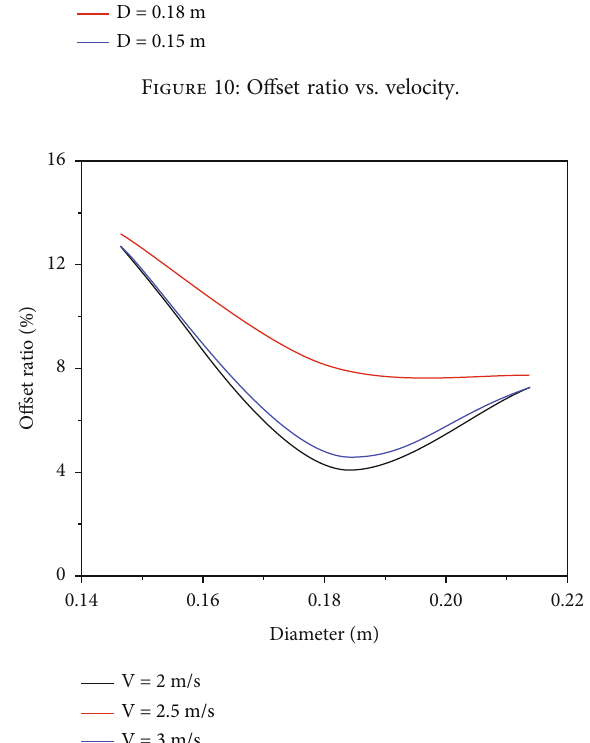
Figure 11: O ff set ratio vs. diameter.